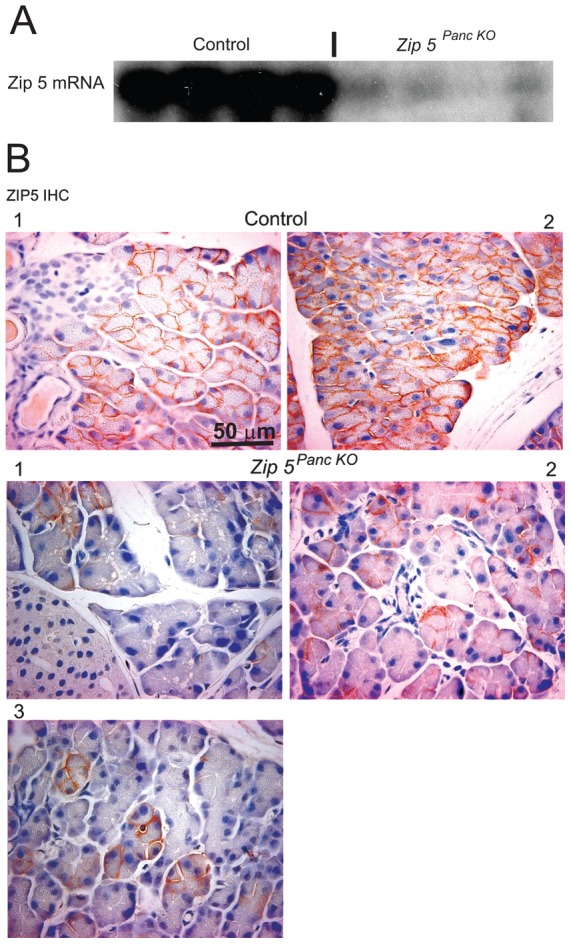
Knockout of the pancreas acinar cell Zip5 gene is mosaic.Newly weaned mice were injected with tamoxifen to induce Zip5 recombination in the pancreas by activation of Cre-ERT2 expressed from an Ela-Cre-ERT2 transgene. (A) Northern blot detection of Zip5 mRNA in the pancreas of control (Control) littermates and pancreas-specific Zip5-knockout (Zip 5 Panc KO) mice killed 5 days after the last tamoxifen injection. (B) Detection of ZIP5 protein using immunohistochemistry (ZIP5 IHC). Paraffin sections of pancreas were incubated with an anti-ZIP5 peptide antibody and specific binding was detected as a dark brown precipitate on the baso-lateral surfaces of acinar cells. Sections from 2 control mice and 3 different knockout mice are shown at 200× magnification. Quantification of the number of ZIP5 immuno-positive and negative cells per field of view in multiple sections from several mice indicated an efficiency of the knockout of ∼70 to ∼90%. In Part B number 1 knockout, the percentage of remaining positive cells was 8% (6/80) indicating a 92% efficacy of the knockout. In part B number 2 knockout, the percentage of remaining positive cells 32% (39/120) indicating an ∼68% efficacy of the knockout. I; indicates Islets of Langerhans: D; indicates a pancreatic duct.